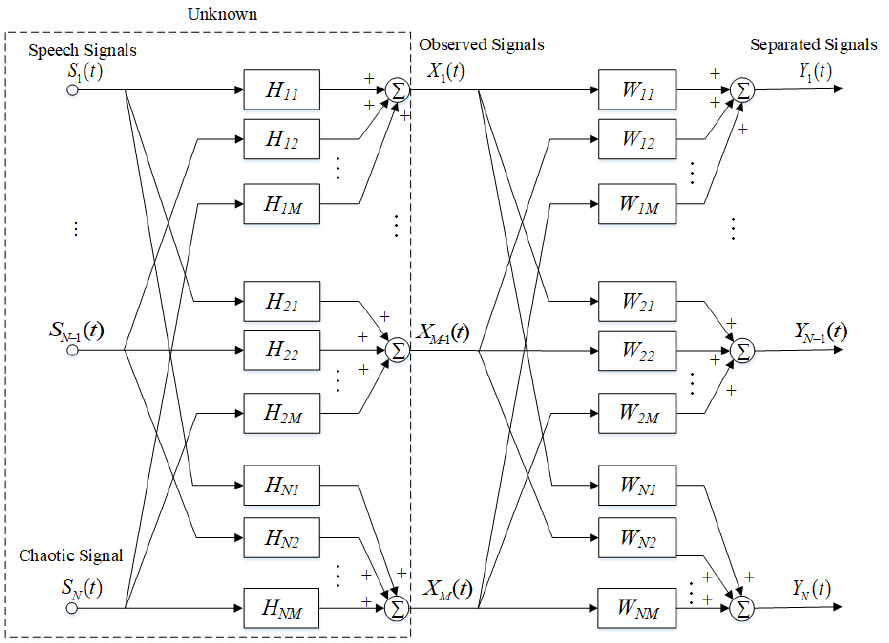
Figure 2. CBSS model for multiple source